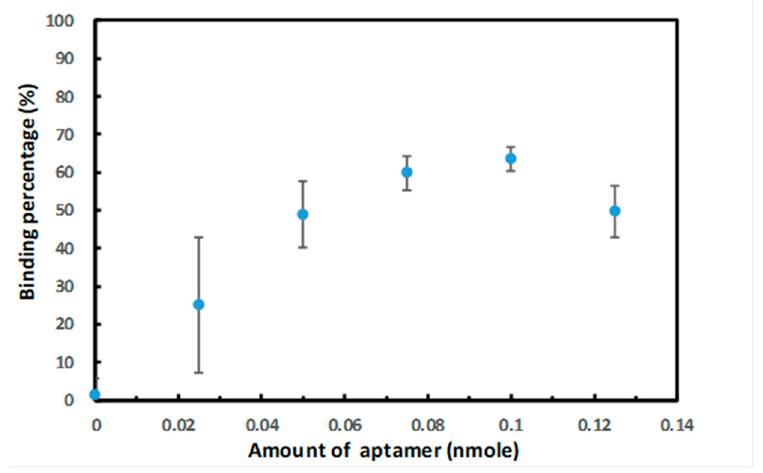
Figure 2. Plot of binding percentage vs. the amount of aptamers conjugated with 1 mg of PAMNPs.